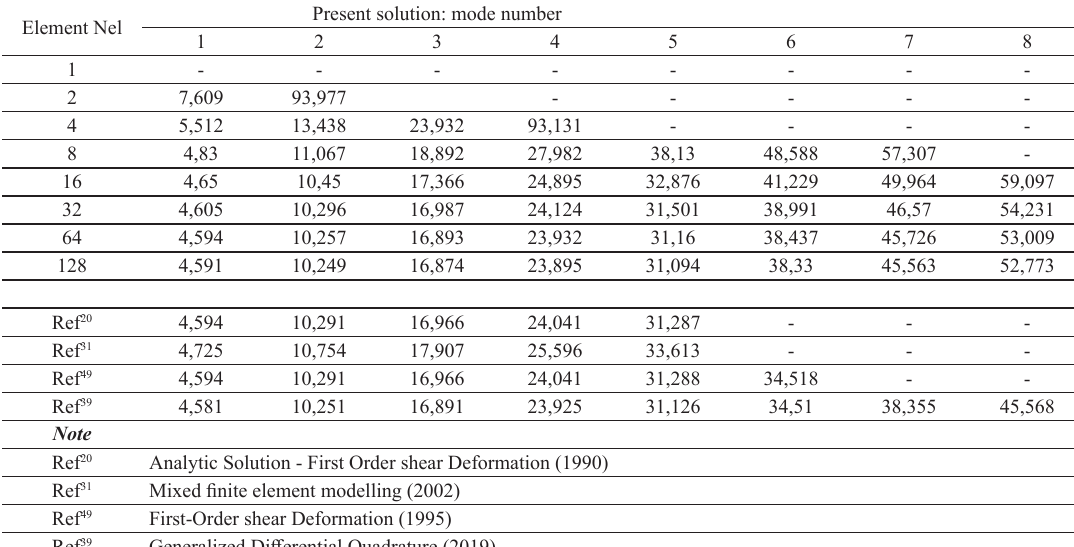
Table 7. Natural frequencies (nondimensional values) for CC beam - Laminated composite with (0/90/90/0) lamination scheme. Model containing parasitic shear. Element